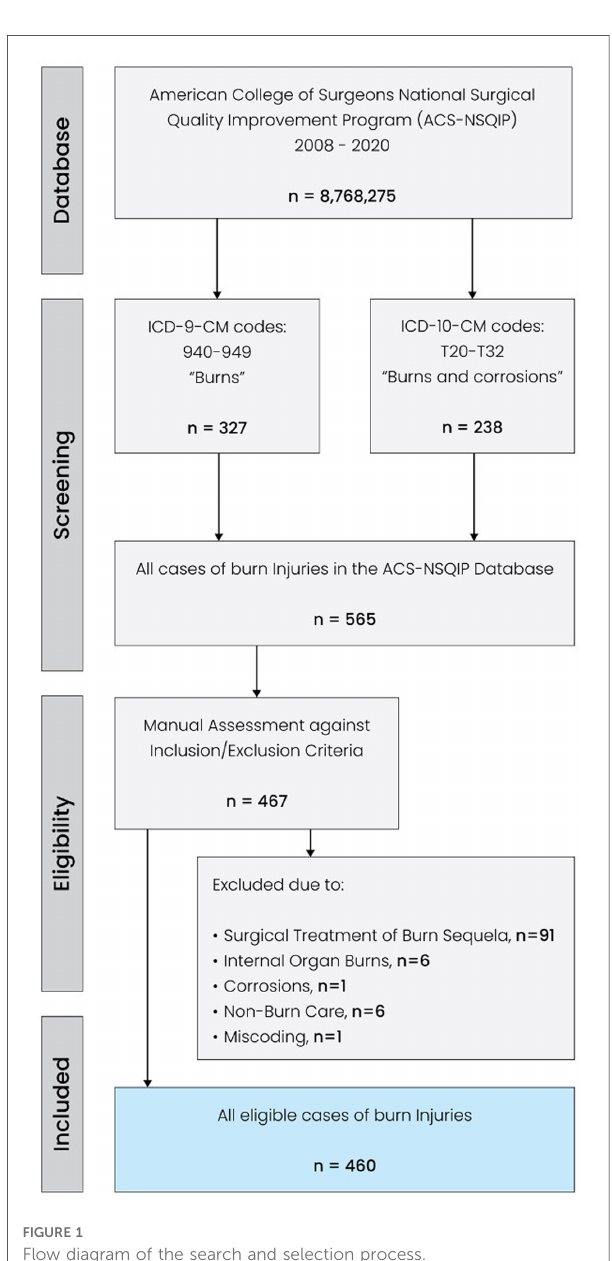
FIGURE 1 Flow diagram of the search and selection